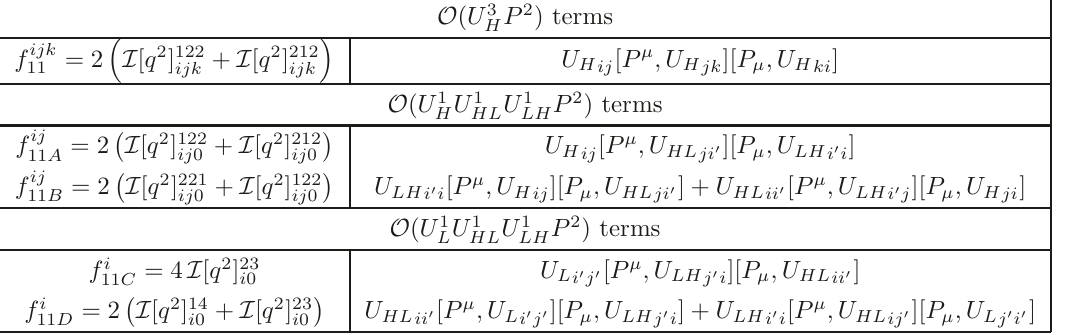
, f ij for operators at O ( U 3 P 2 ). There are 5 terms: 1 11 11 A,B,C,D